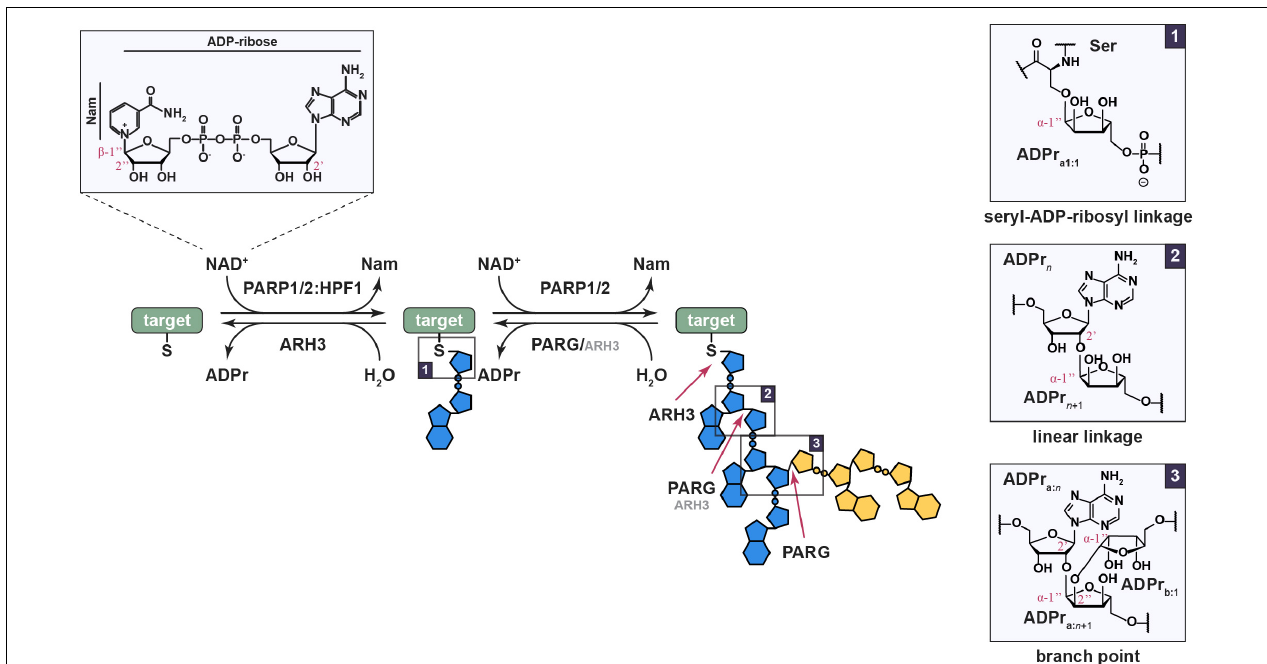
FIGURE 1 | Ser-ADPr is a reversible and complex modification. The reaction involves the transfer of the ADPr moiety from β -NAD + under inversion at the anomeric carbon, thus resulting in a modification in the α -conformation. The initial modification of a serine residue is catalyzed by the PARP1/2:HPF1 complex (box 1), while further chain extension is catalyzed by PARP1/2 alone. The latter occurs as linear, ribose(1 (cid:48)(cid:48) → 2 (cid:48) )ribose (box 2), or infrequently branched, ribose(1 (cid:48)(cid:48) → 2 (cid:48)(cid:48) )ribose(1 (cid:48)(cid:48) → 2 (cid:48) )ribose (box 3), continuations leading to a large and diverse polymer structure. Linear polymers are primarily degraded by PARG, and to a lesser extend ARH3, while branch pruning, hydrolysis of the 1 (cid:48)(cid:48) → 2 (cid:48)(cid:48) bond, is carried out solely by PARG and precedes the cleavage of the 1 (cid:48)(cid:48) → 2 (cid:48) bond at branch points. In contrast, the proximal seryl-ADP-ribosyl bond can only be cleaved by ARH3. Identified target proteins in the context of the DDR include PARP1 and 2 themselves (automodification), histones (primarily H2B, H3, H4, and H1), FEN1, LIG3, and